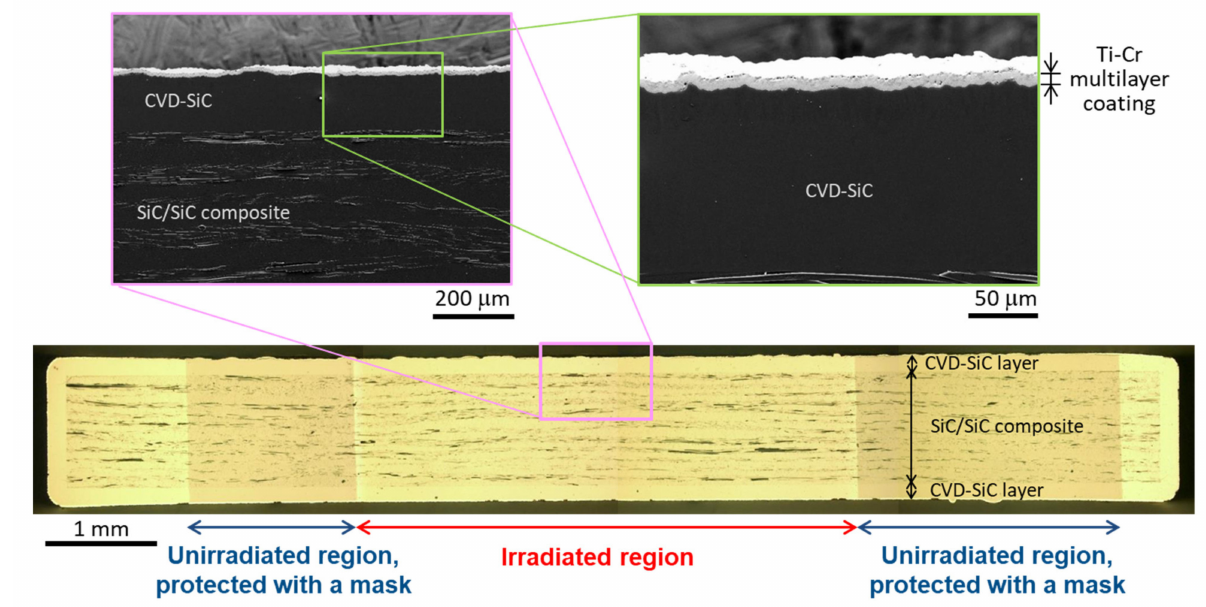
Figure 5. Cross section of Ti-Cr multilayer-coated SiC after irradiation with 5.1-MeV Si 2+ ion at 573 K at a fluence of 2.85 × 10 20 ions/m 2